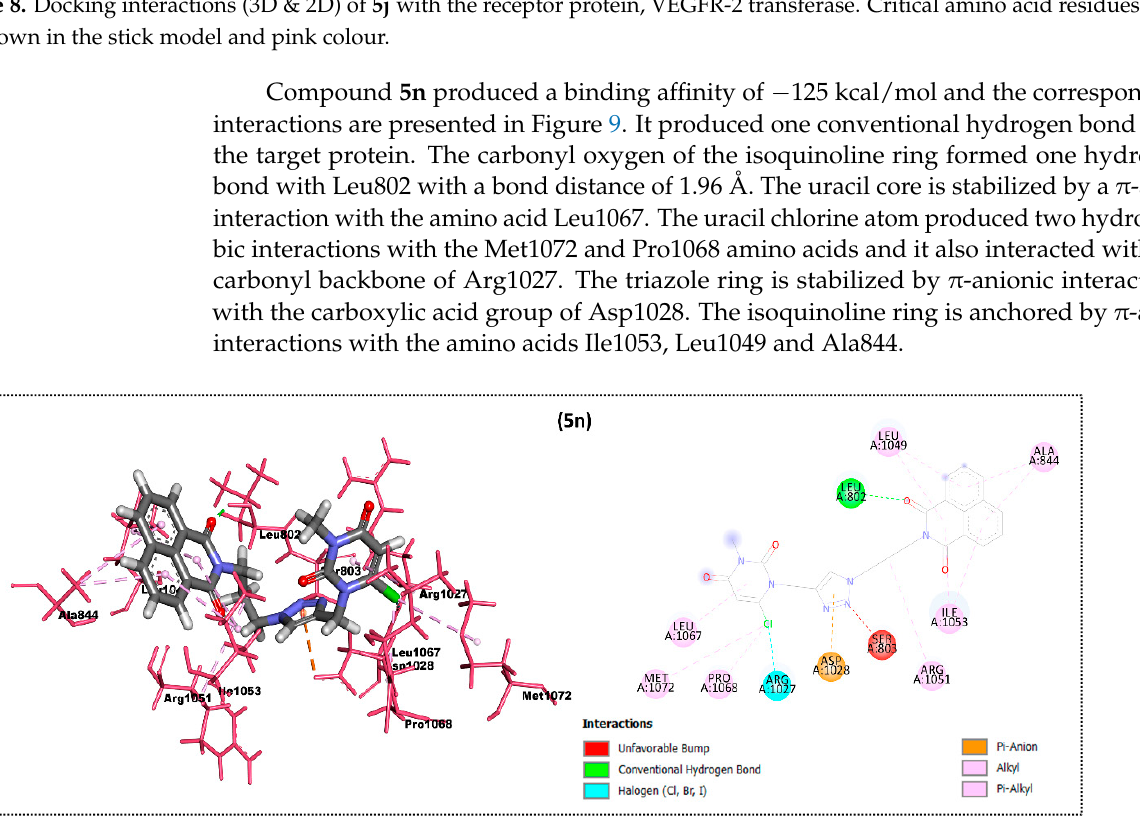
Figure 9. Docking interactions (3D & 2D) of 5n with the receptor protein, VEGFR-2 transferase. Critical amino acid residues are shown in the stick model and pink colour.